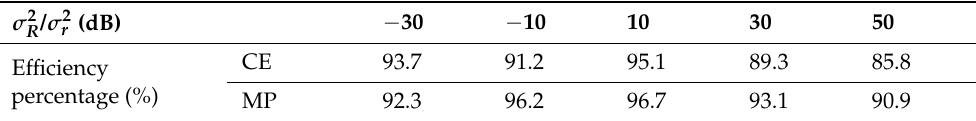
Table 4. Efficiency percentage of CE and MP methods (Simulation 4).